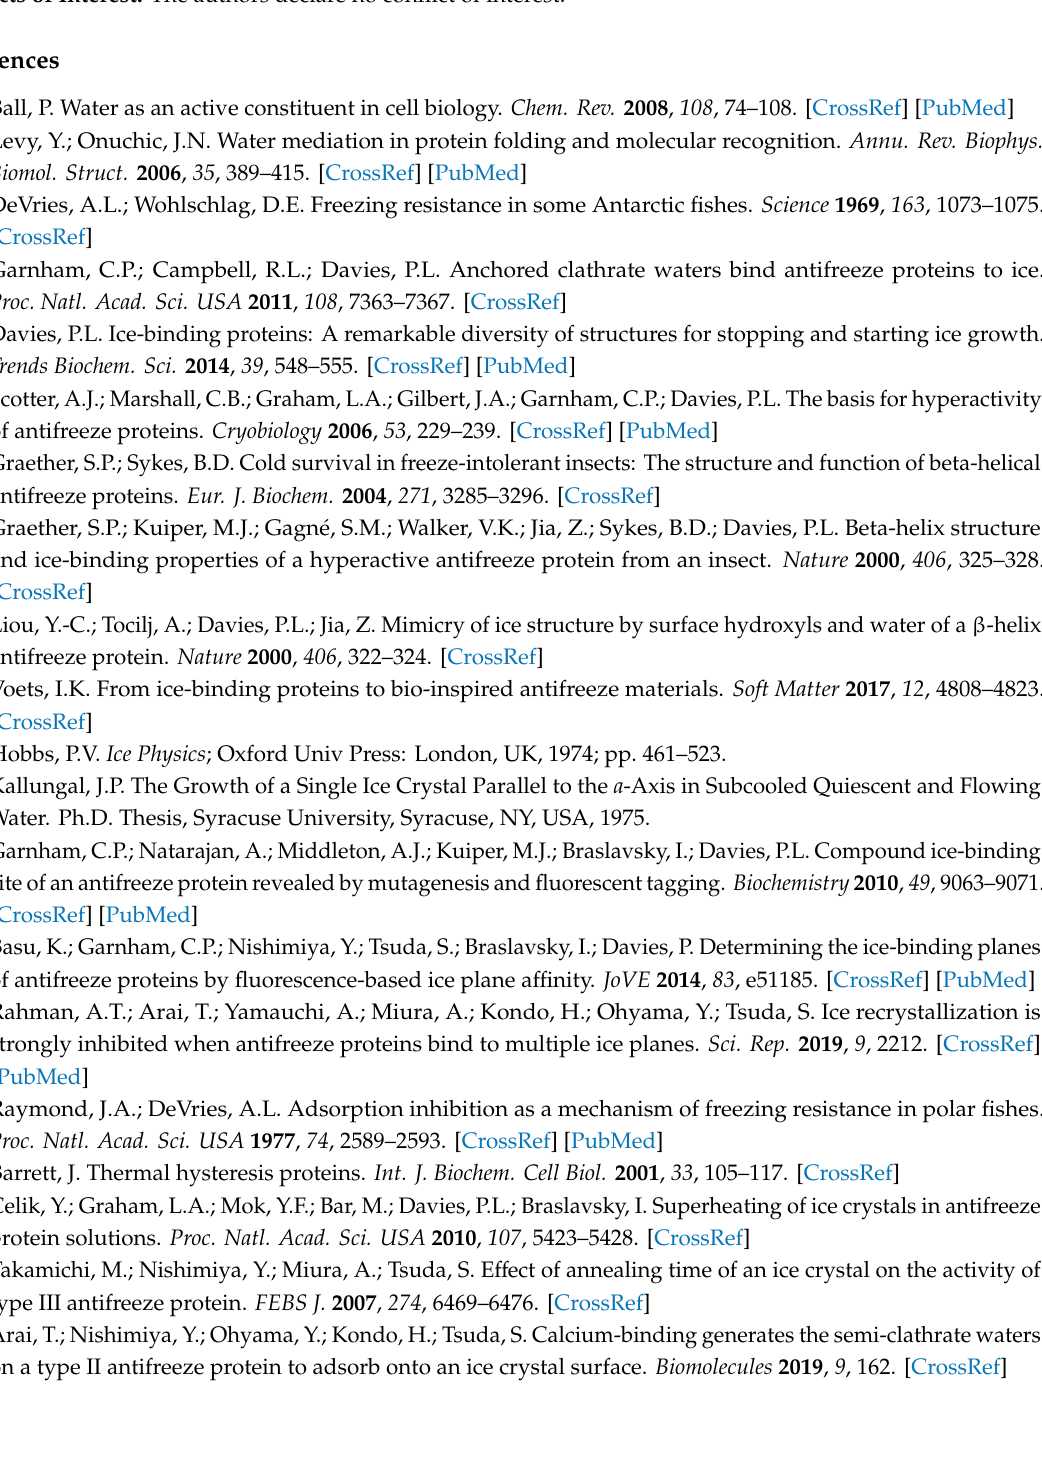
Table S1: Data collection and refinement statistics for wild-type Anp IBP and S153Y; Figure S1: Crystal packings of wild-type Anp IBP and its mutant (S153Y); Figure S2: Circular dichroism (CD) spectra of wild-type Anp IBP and its mutants (S153Y and